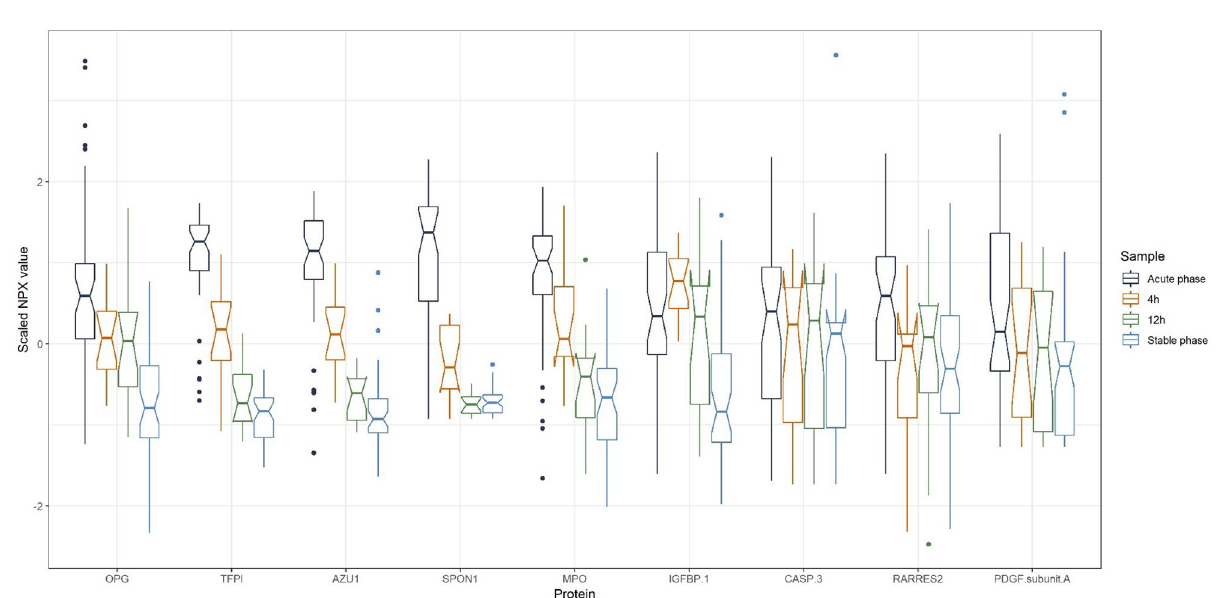
Figure 5. Box plots for the time-points acute phase, 4 h, 12 h, and stable phase for the nine proteins in clustering group 6. Notches determine the 95% confidence interval for the median value. On the y-axis scaled NPX values are shown. The scaled NPX values cannot be compared directly between proteins, but only between measurements of the same protein. This figure was made with the R software package called ggplot2,